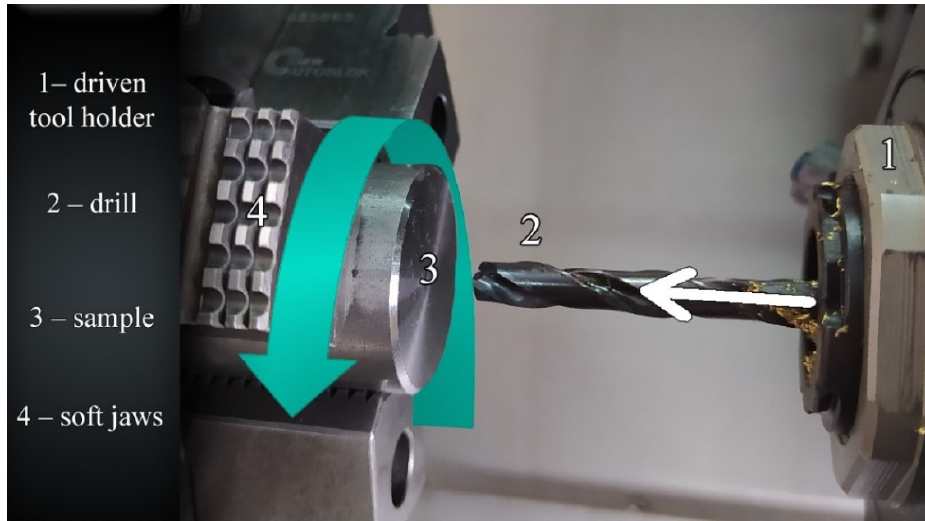
Figure 2. Second kinematic system.